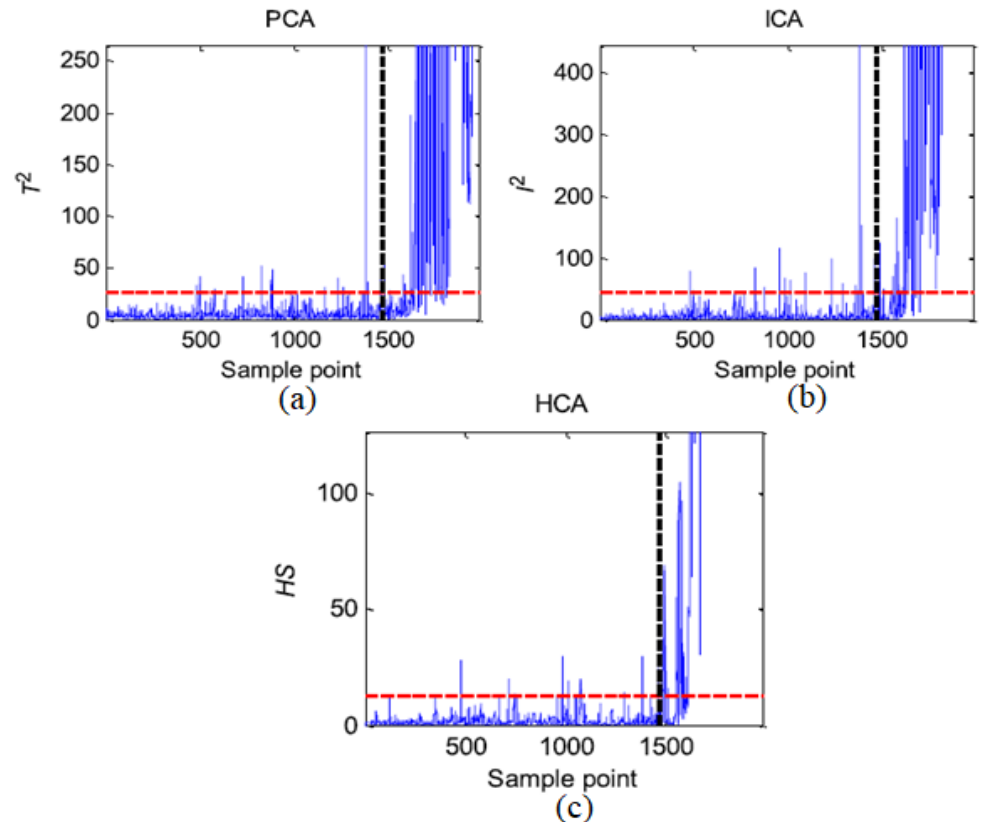
Figure 29. Dynamic monitoring of bearing faults by ( a ) PCA, ( b ) ICA, and ( c ) HCA approaches. Reproduced with permission of [77] (The X label shows the total number of sample points, and the Y-label shows the number of training samples).